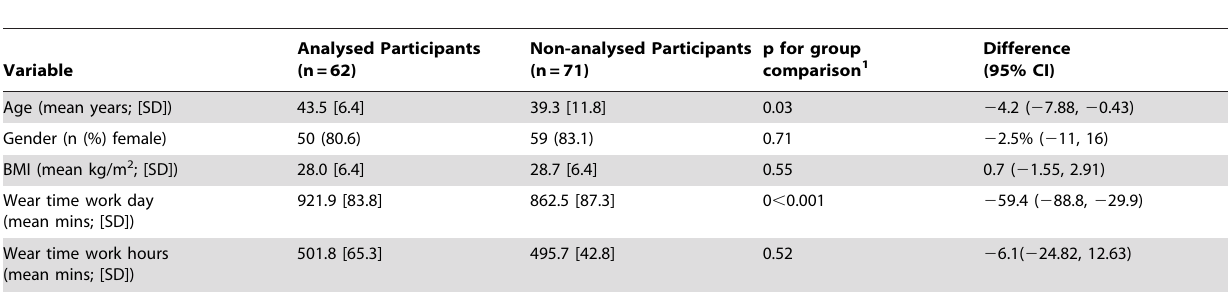
Table 2. Comparison of participant characteristics and activity levels at baseline between participants that were analysed and those not included in